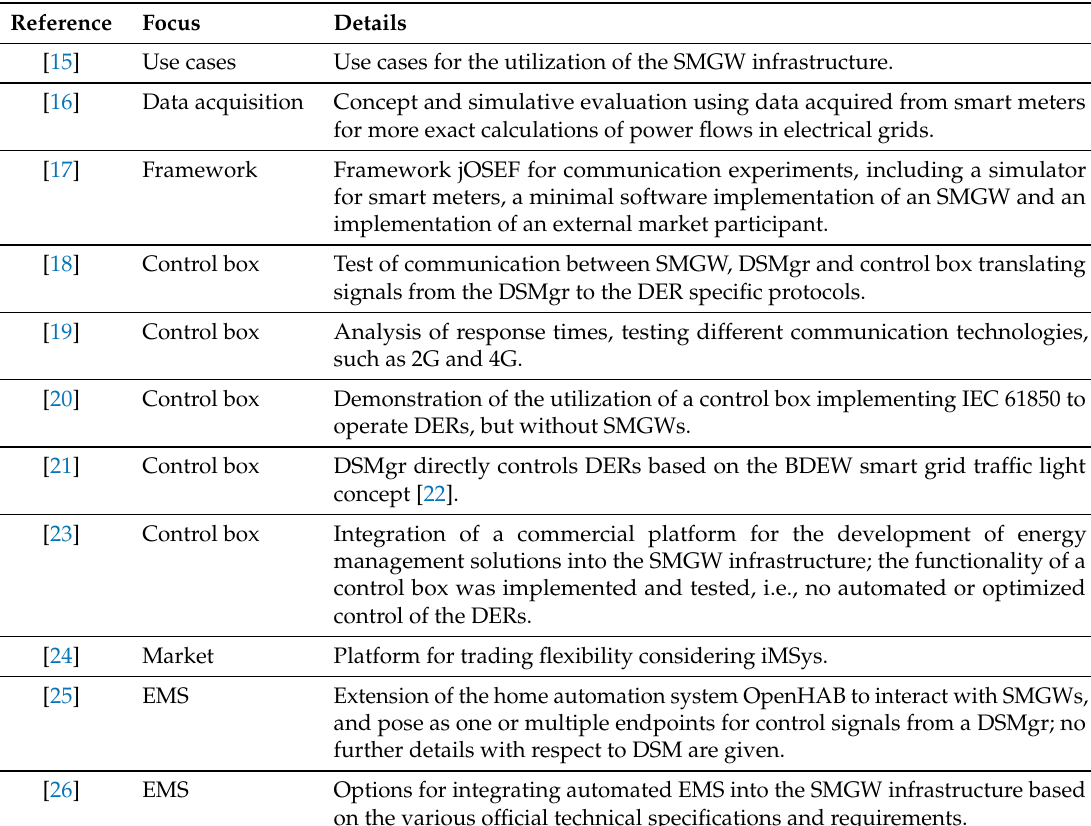
Table 1. Related scientific work based on Smart Meter Gateways